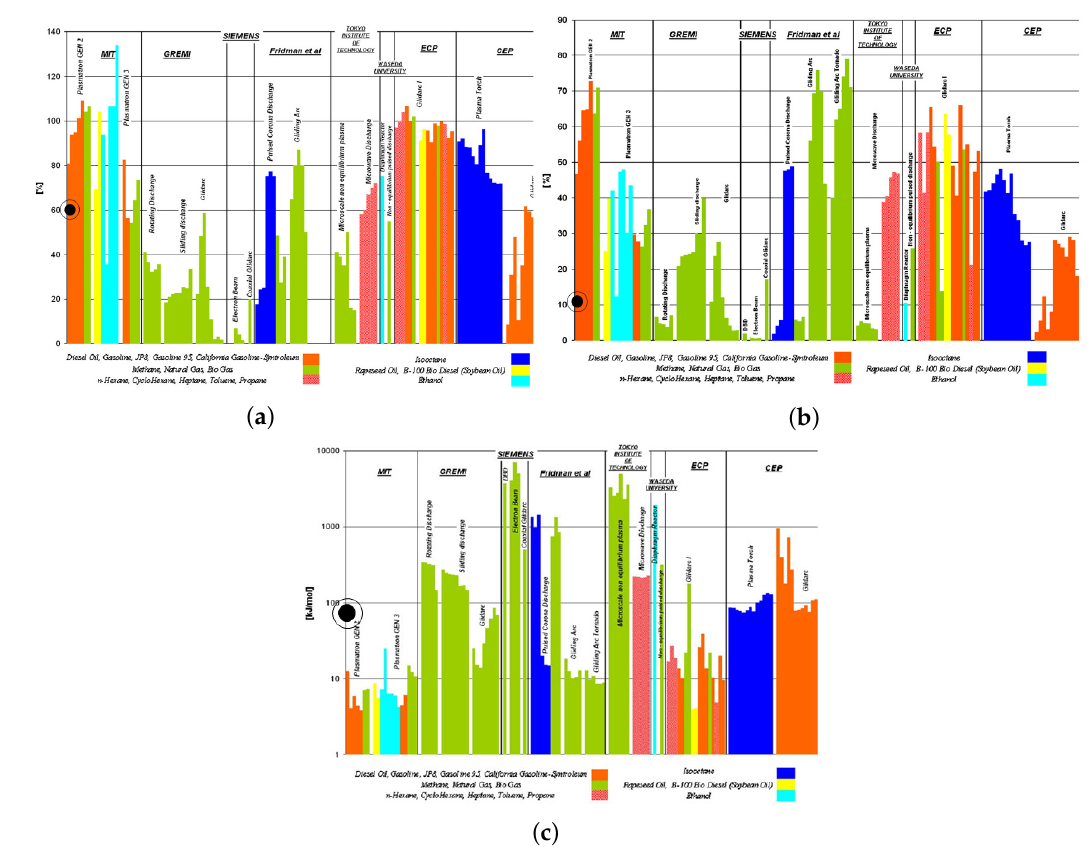
Figure 7. Performance parameters and comparison of 3DGAVR: ( a ) conversion rate; ( b ) efficiency; and ( c ) specific energy requirement. Reproduced with permission from